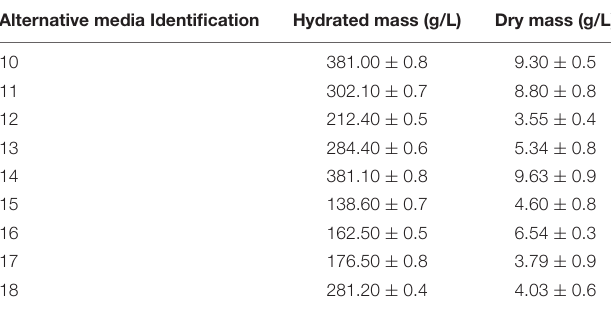
TABLE 4 | Hydrated and dry mass obtained from alternative media formulated with glucose and